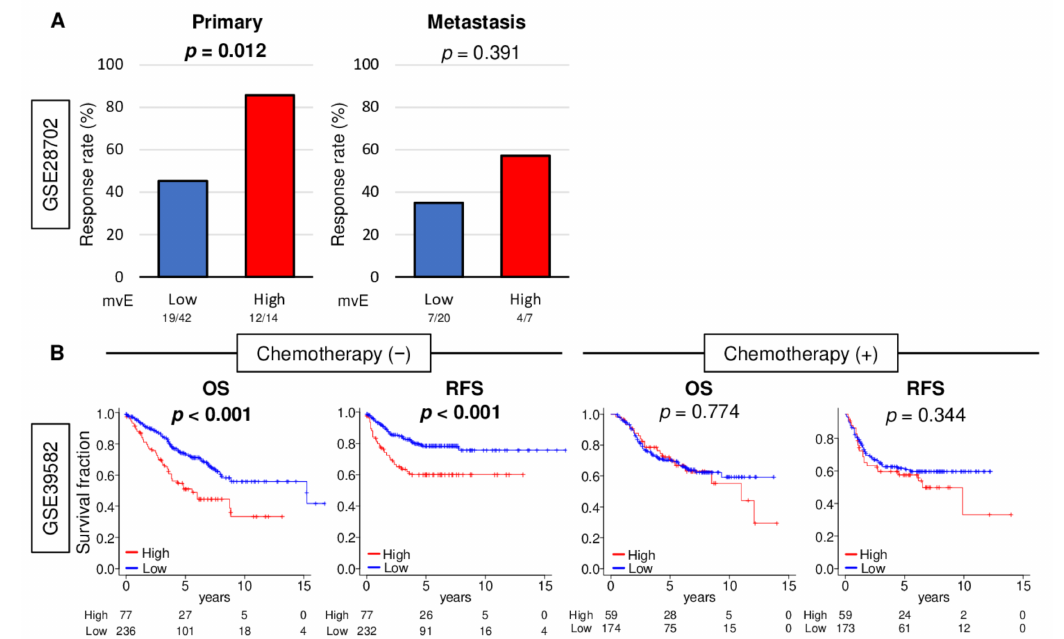
Figure 6. Association between amount of mvE cells with treatment response. ( A ) Bar plots of pathological response rate for chemotherapy for primary and metastasis between high (red) and low (blue) mvE cells score in the GSE28072 cohort. ( B ) Kaplan–Meier with p -value between high (red) and low (blue) mvE cells with overall survival (OS) and recurrence- free survival (RFS) in the treatment group and non-treatment group in the GSE39582 cohort. p -value was calculated by log-rank